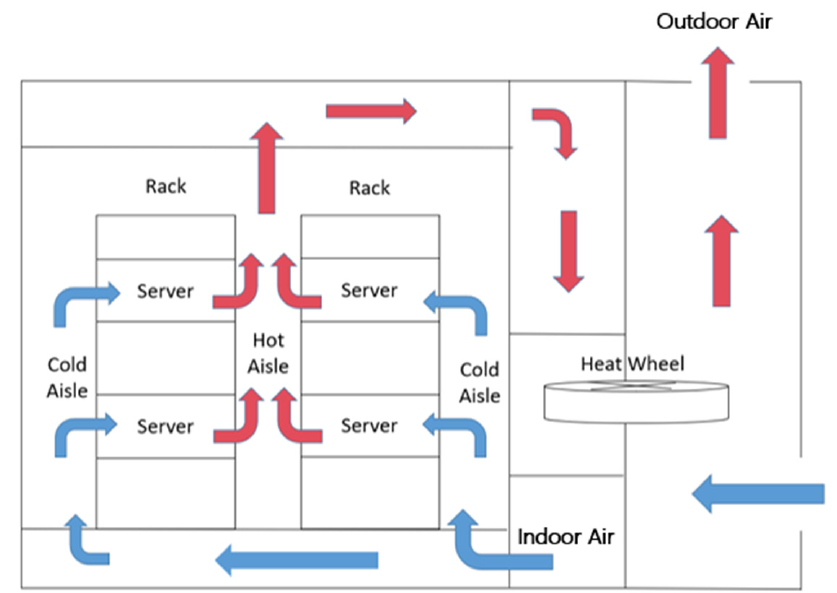
Figure 4. Wheel indirect air cooling system [32].